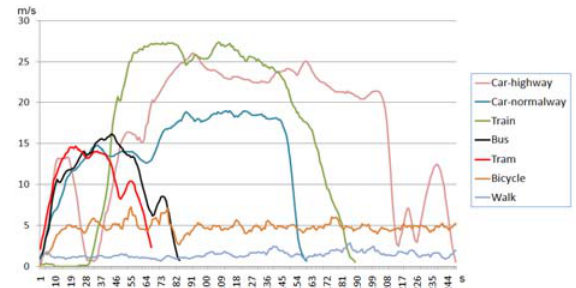
Figure 2. Typical speed patterns of different travel-mode segments